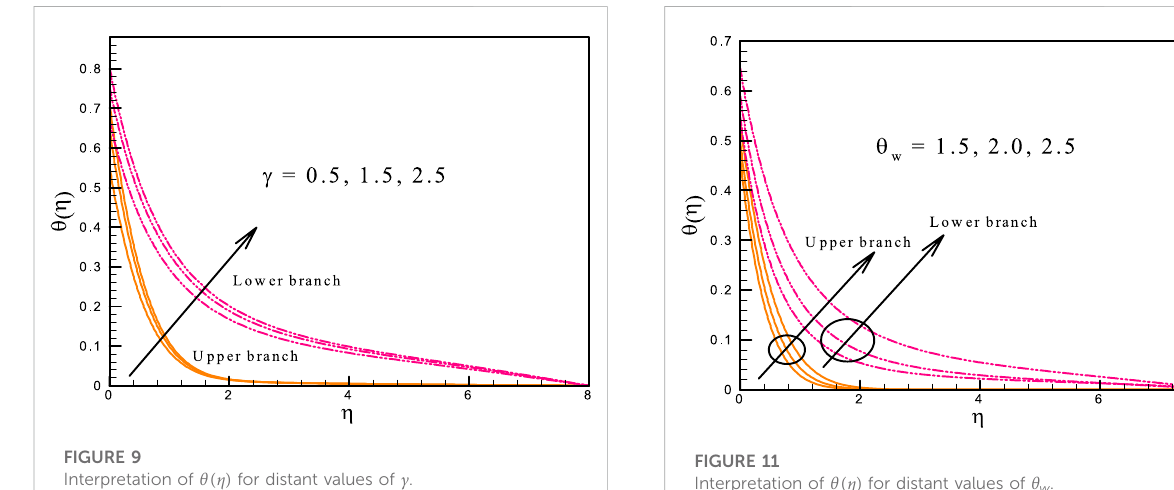
FIGURE 9 Interpretation of θ ( η ) for distant values of γ .